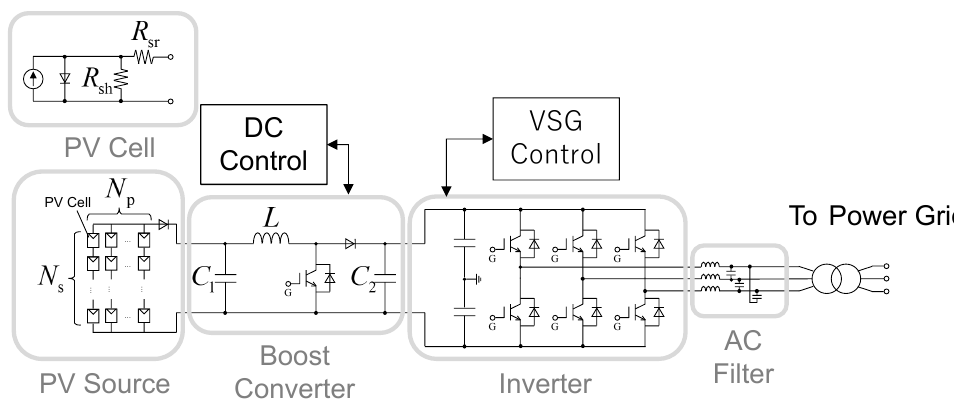
Figure 2. Circuit diagram of the two-stage PV-VSM. Table 1. Circuit parameters of the two-stage